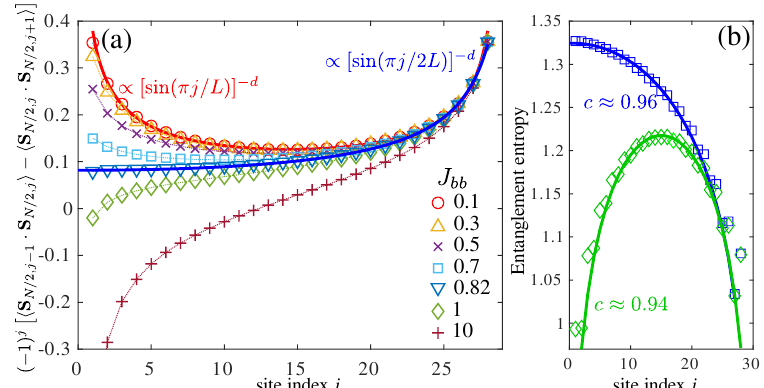
Figure 8: (Color online) (a) Friedel oscillations along the middle tooth for various backbone couplings in a comb with L = 30 sites per tooth and N = 30 teeth. Red and blue lines corresponds to the CFT fit with chain length L and 2 L correspondingly. (b) Entanglement entropy profile along the middle tooth for J (blue); lines are fit to the Calabrese-Cardy formula.